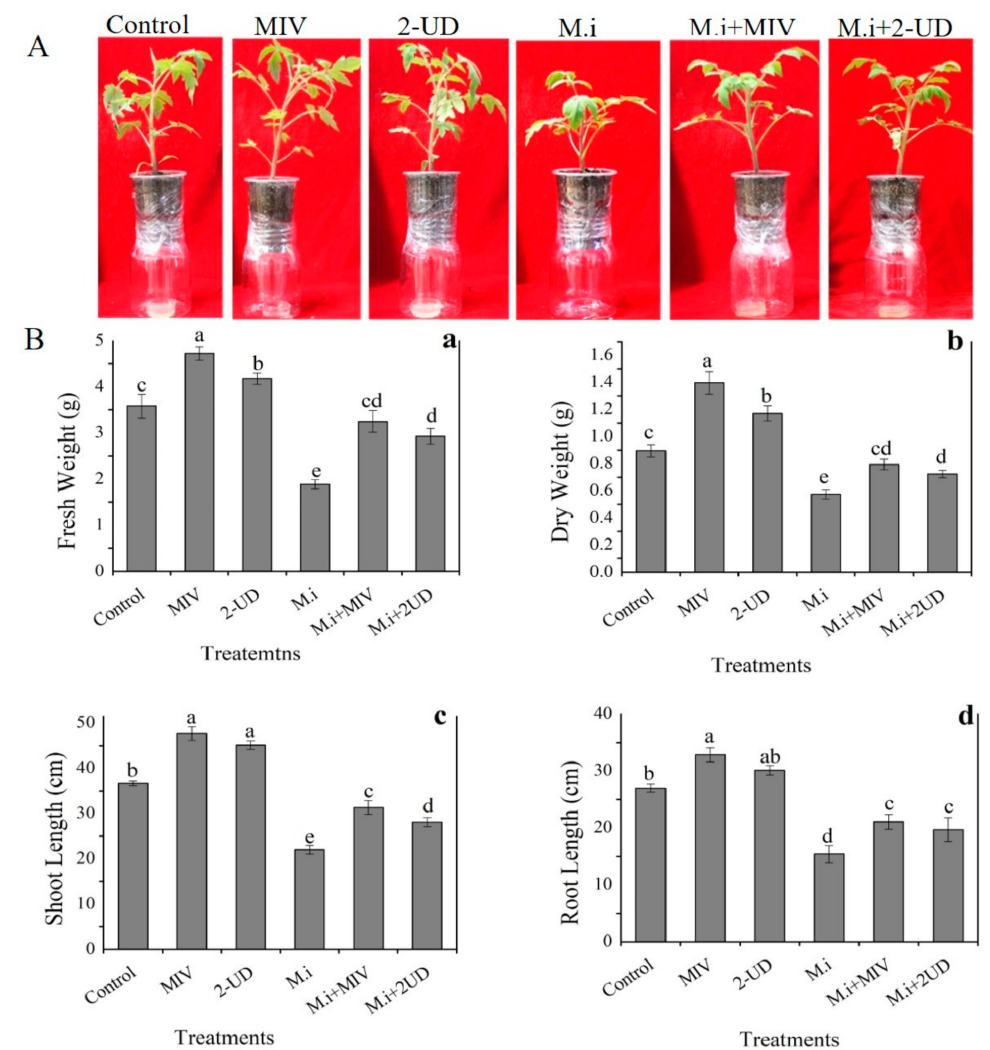
Figure 7. The effect of MIV and 2-UD M. incognita (M.i)-infested tomato plant in a pot experiment. The healthy plants having no M.i were used as control. ( A ) Visual presentation of the effect MIV and 2-UD on tomato plant growth. ( B ) Graphical display of the above VOCs on growth promotion by calculating different parameters: ( a ) fresh weight, ( b ) dry weight, ( c ) shoot length, ( d ) root length. The error bar represents the mean standard deviation of each treatment repeated three times with three replicates. The small letters above the columns indicate significant difference. The significant difference between different treatments was calculated through Tukey’s HSD test at p ≤